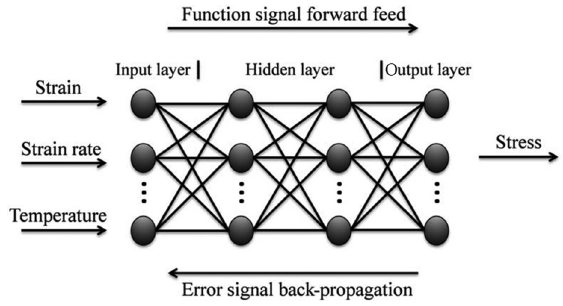
Figure 7 Schematic illustration of the neural network